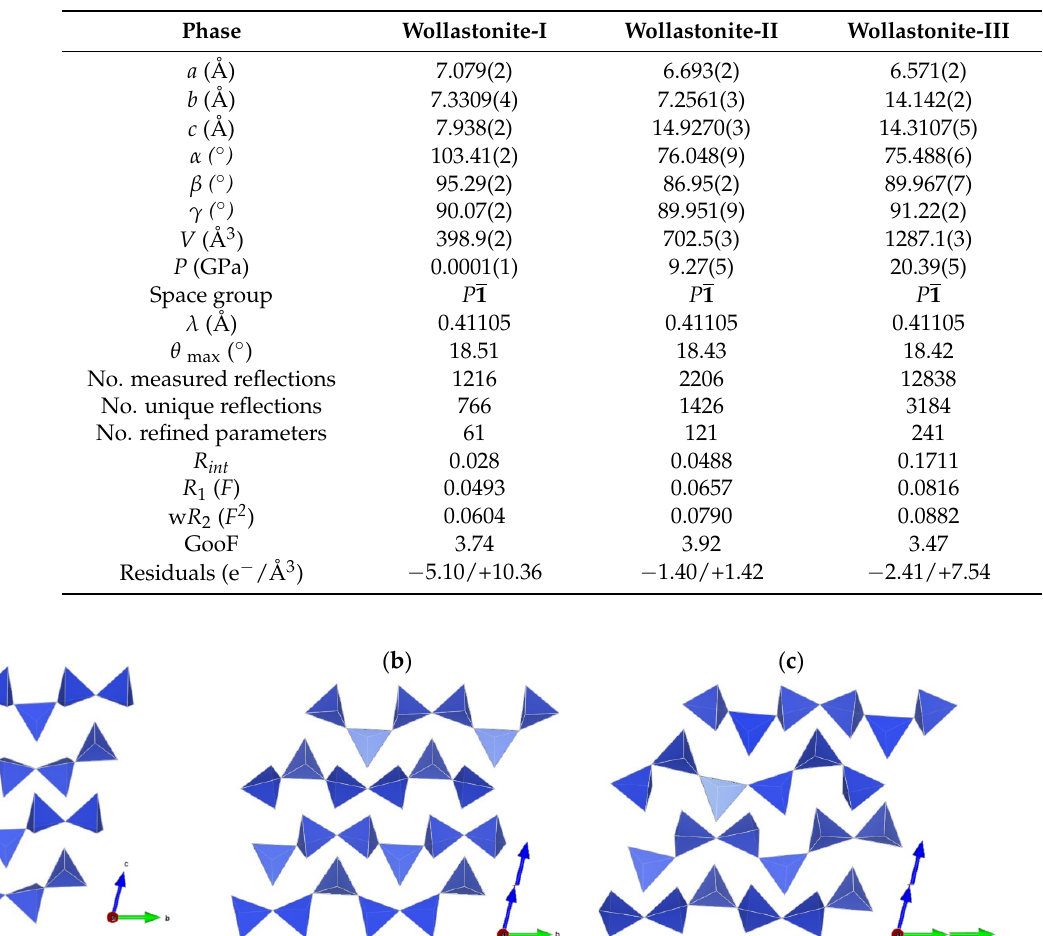
Table 3. Details pertaining to the data collections and structure refinements of wollastonite studied in this work.